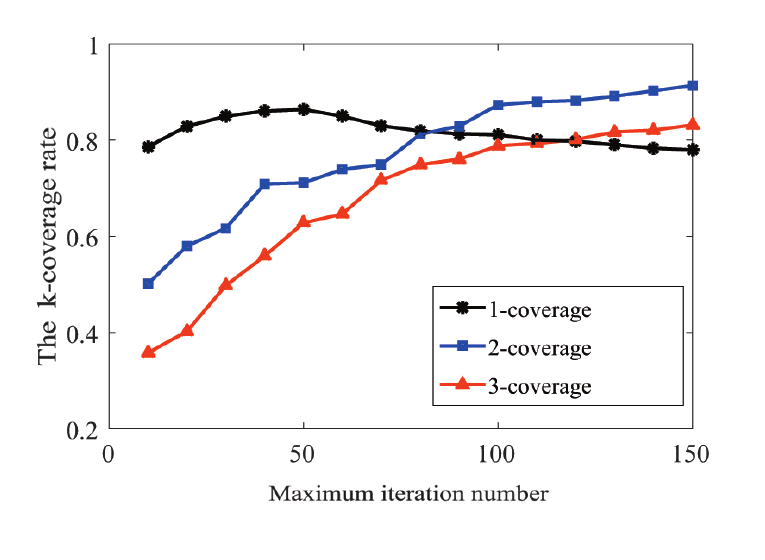
Figure 11. The correlation between N max and the k -coverage